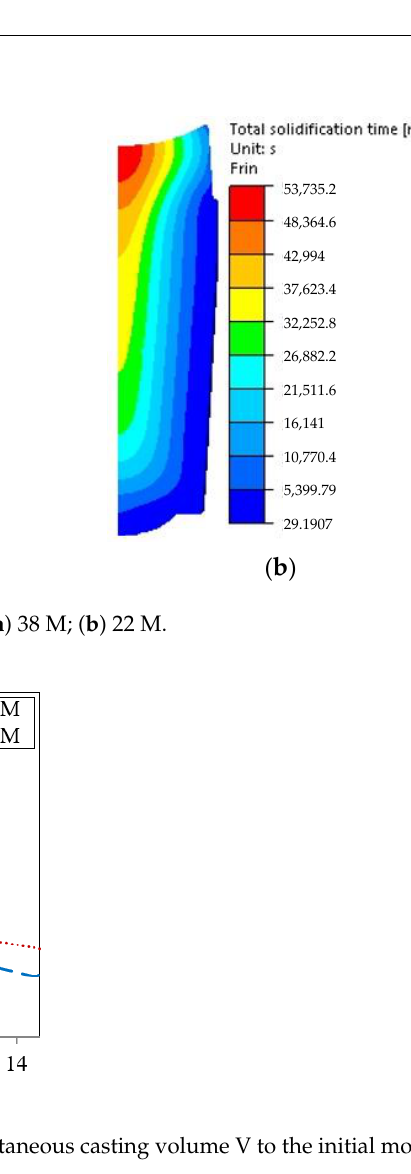
Figure 7. Temperature fields predicted by 38 M and 22 M at times of: ( a , d ) end of filling; ( b , e ) 5.5 h; ( c , f ) 10.5 h.